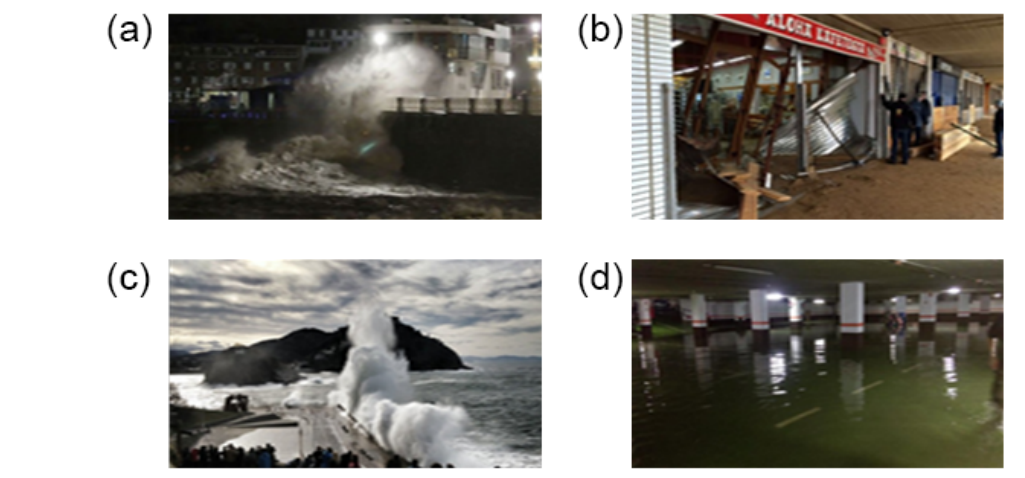
Figure 9. Images of impact and damage from Zarauz and Donostia: waves battering the maritime club of de city of Donostia (a) , damage on the Zarautz beach boardwalk (b) , waves overtopping the promenade area of Paseo Nuevo in Donostia (c) and garage flooding in Donostia (d) .